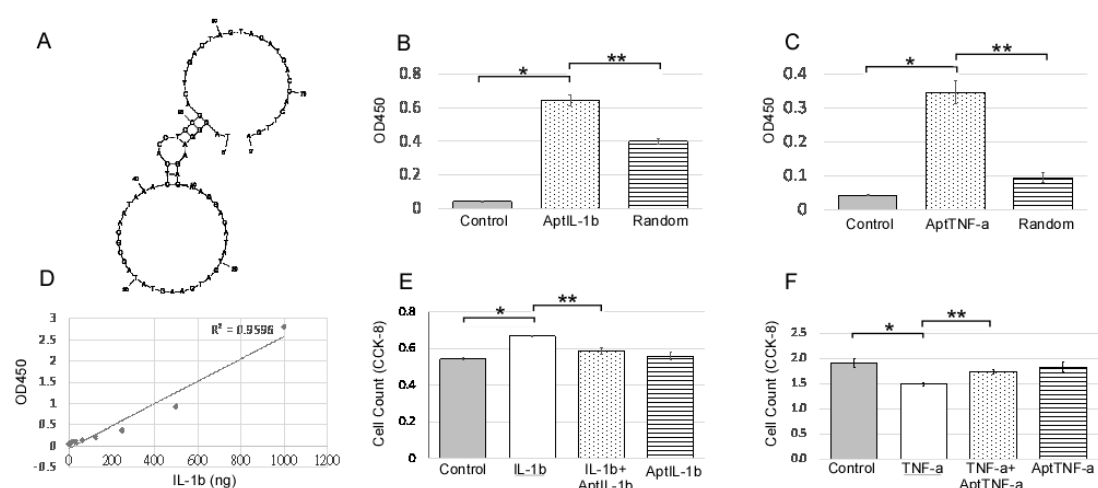
Figure 1. IL-1b-targeting aptamer (AptIL-1b) binds to IL-1b with high affinity and serves as a molecular probe for detecting IL-1b in vitro. ( A ) The predicted secondary structure of AptIL-1b. ( B ) The binding of AptIL-1b and human IL-1b; AptIL-1b binds to human IL-1b fixed in a plate ( n = 3). ( C ) In vitro detection of the tumor necrosis factor-alpha (TNF-a) signals by TNF-a-targeting aptamer (AptTNF-a) or a random sequence pool in a plate fixed with human TNF-a ( n = 3). ( D ) Dose-dependent binding of AptIL-1b to IL-1b demonstrated a standard curve in enzyme-linked immunosorbent assay (ELISA) by replacing primary antibody with AptIL-1b. ( E ) The proliferation of the Jurkat cell line detected with Cell Counting Kit-8 (CCK8, Sigma-Aldrich, Product No. 96992) at 48 h after IL-1b with/without aptamer administration (n = 3). ( F ) The proliferation of murine urothelial cell line detected with CCK8 at 48 h after the administration of TNF-a with/without aptamer ( n = 3). The data are presented as mean ± standard error of the mean and were analyzed by Student’s t-test. Asterisks denote statistically significant differences. * p < 0.05 represents a significant difference for the CPPS group compared with the sham-operated control group. ** p < 0.05 represents a significant difference for the CPPS + ICTA group compared with the CPPS group ( P < 0.05).